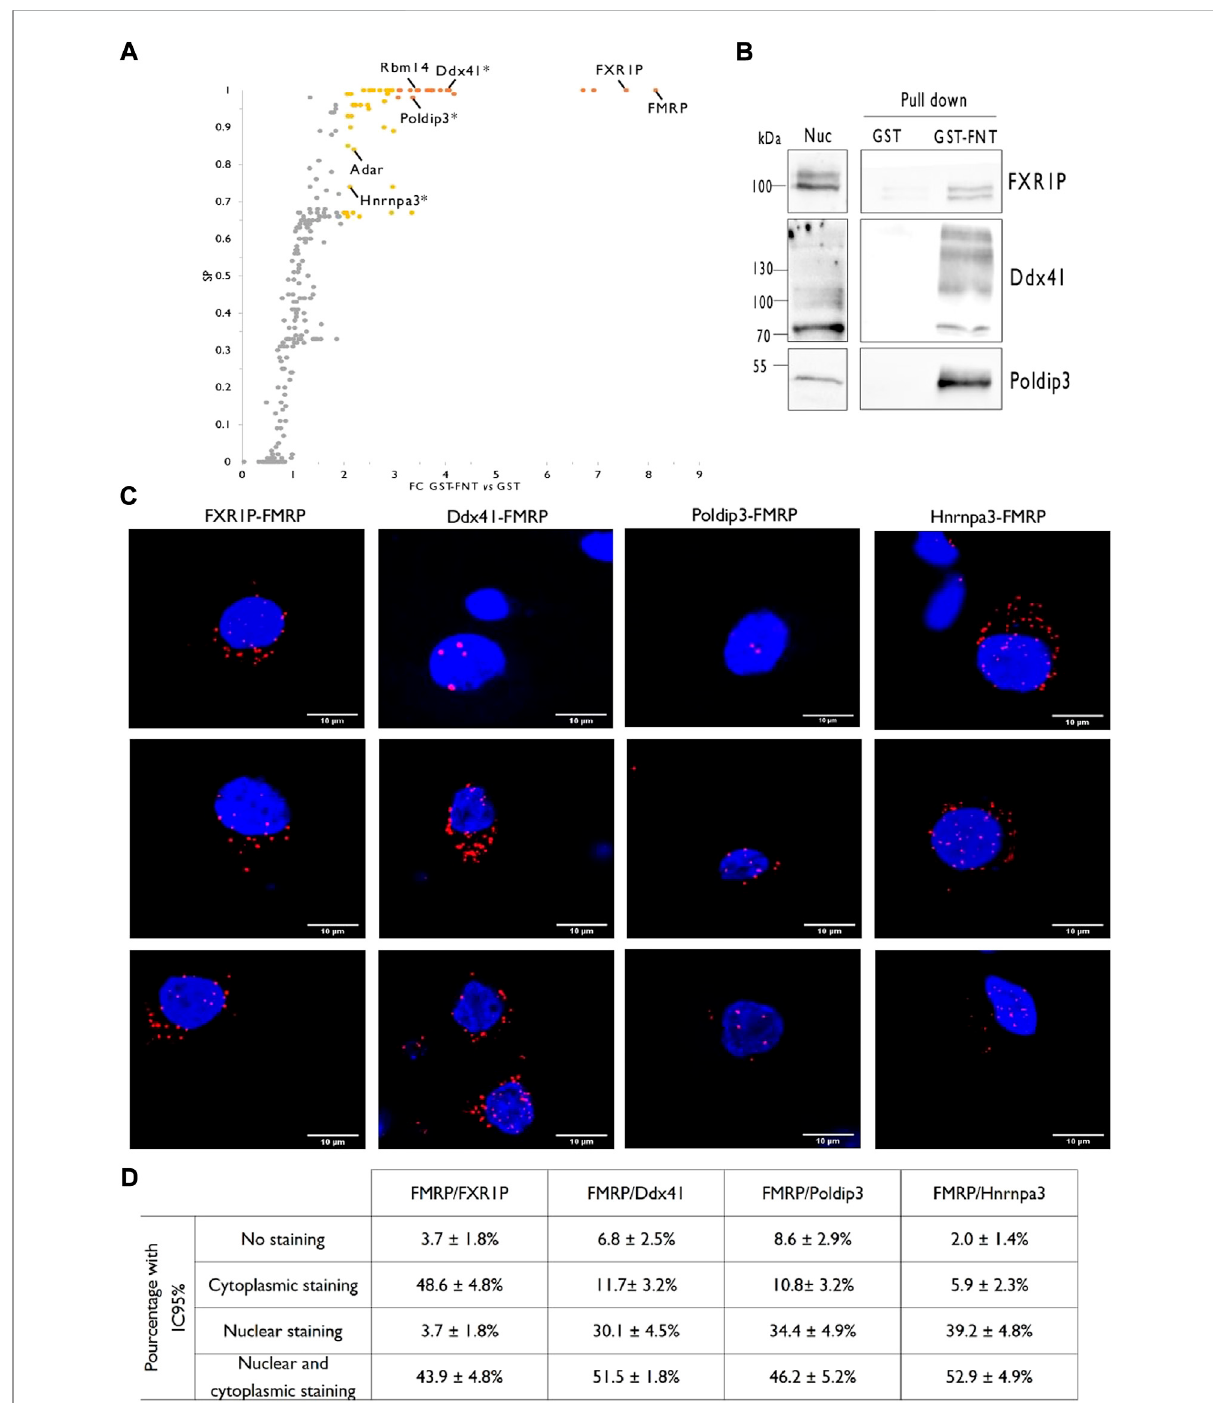
Identi fi cation of rat forebrain nuclear FMRP-interacting proteins. (A) . Volcano plot highlighting proteins differentially co-puri fi ed in triplicate pull-down experiments using the GST-FNT recombinant protein versus the GST alone. Statistically signi fi cant differences were assessed using the Saint-Express tool. Unenriched proteins are displayed in gray, while enriched proteins presenting a FC > 3.00 and SP > 0.7 are displayed in orange, and were classi fi ed as “ high-con fi dence ” interactor. Yellow dots corresponding to all other signi fi cant proteins with FC > 2.0 and SP > 0.5, and were referred as “ medium-con fi dence ” interactor. Know and novel (*) FMRP interacting proteins are noted in the scatter plot. (B) . Immunoblot analysis of identi fi ed FMRP-interacting proteins. Pull down experiments were conducted with GST-FNT and GST (negative control) immobilized on Glutathione Sepharose with nuclear fractions. Protein retained on the beads were resolved by SDS-PAGE and processed for western blotting using antibodies against FXR1P, Poldip3 or Ddx41. (C) . Representative confocal images of the interaction between endogenous FXR1P, Ddx41, Poldip3